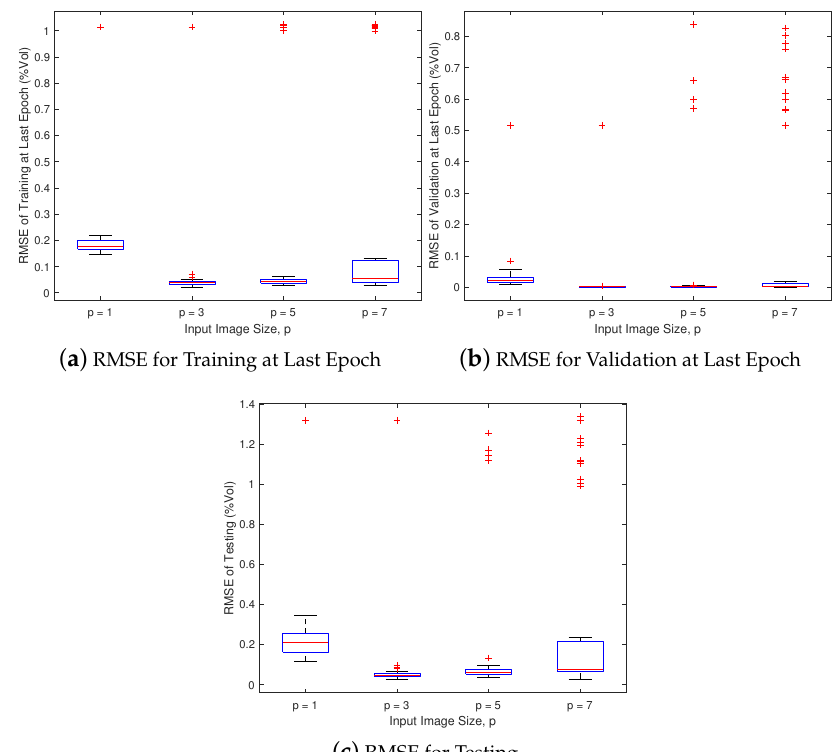
Figure 10. Training, validation, and testing with errors on pixels for measurement points in multispectral